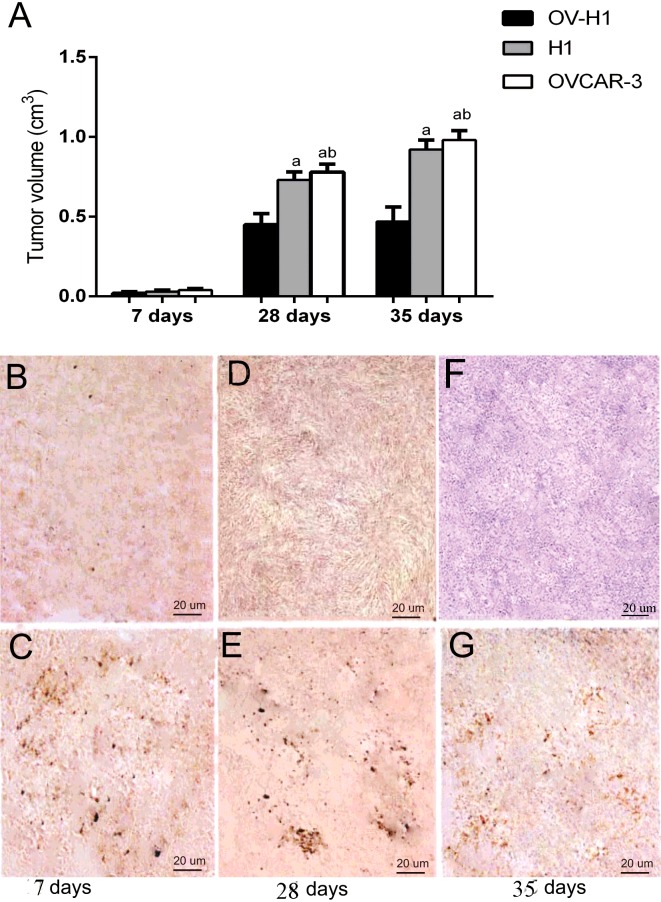
In vivo results of tumors growth and cells apoptosis(A) In vivo results of tumours growth between groups at different time point. Note: a, compared with the OV-H1 hybrid cells, P< 0.05; b, compared with the values between hESCs and OVCAR-3 ovarian cancer cells, P>0.05. (B–G) In vivo results of TUNEL apoptotic cell detection at 7 days, 28 days and 35 days. (B, D and F) The experimental group; (C, E and G) the control group.